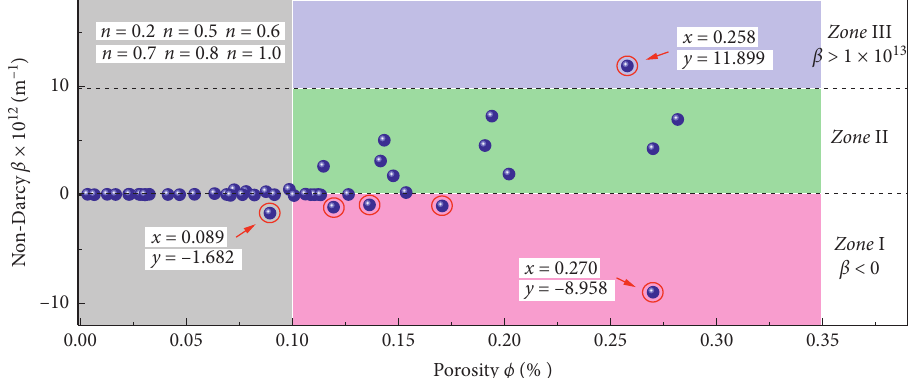
Figure 7: Distribution of β -factors in non-Darcy flow in the tested